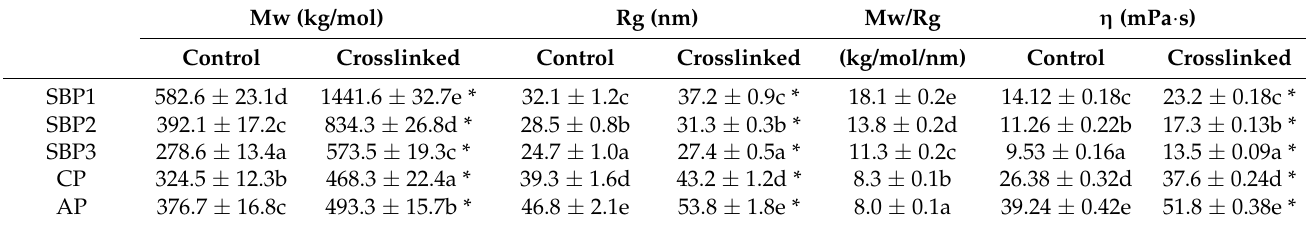
Table 2. Molecular weight (Mw) and radius of gyration (Rg) and apparent viscosity ( η ) of the pectin before and after genipin crosslinking a